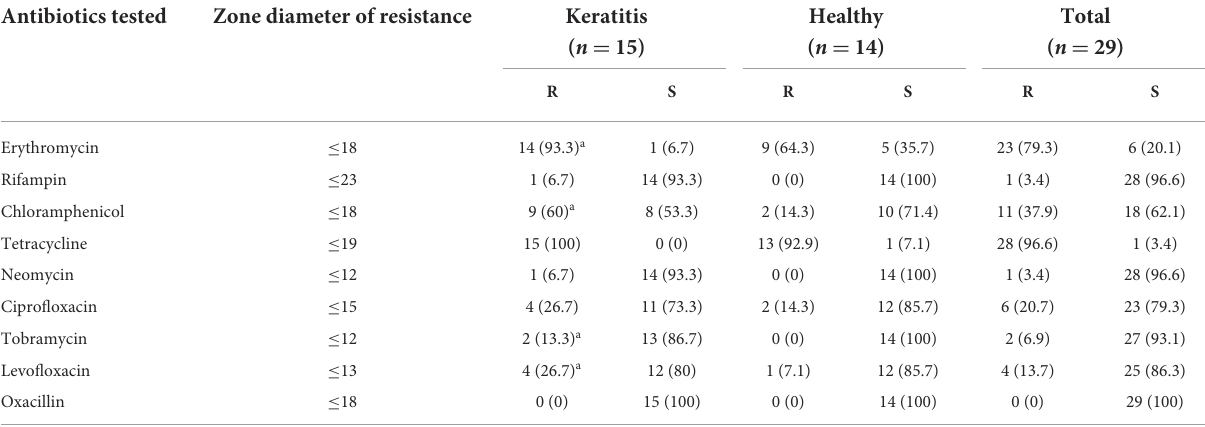
TABLE 4 Antimicrobial resistance of the 29 isolates of S. pseudintermedius from canine eyes. Antibiotics tested